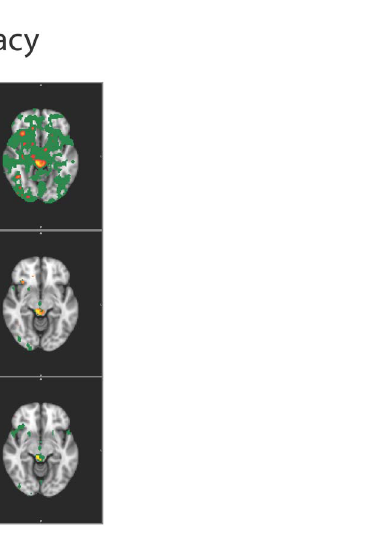
Table 1. Size of areas in limbo for different thresholds.